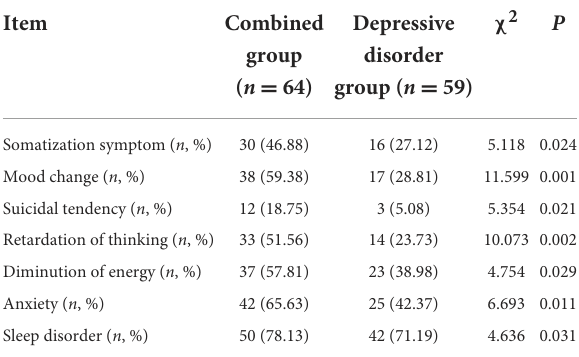
TABLE 2 Comparison of clinical symptoms between the combined group and the depressive disorder group.